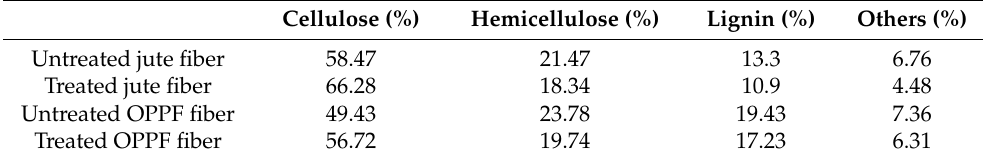
Table 2. Compositional Analysis of the Fibers.